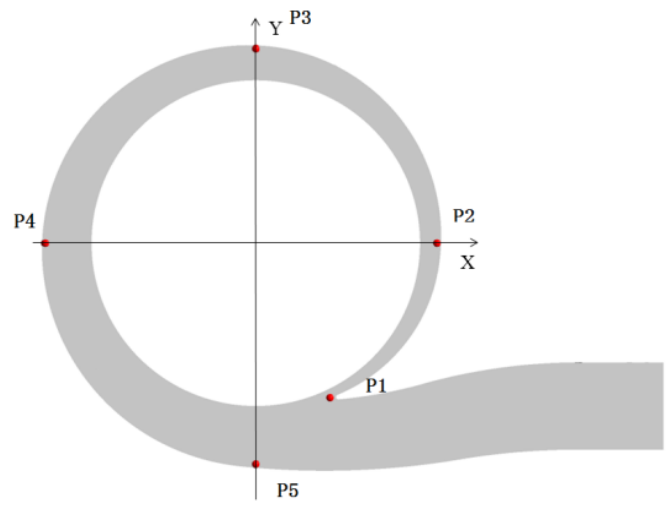
Figure 15. Position setting of the pressure monitoring nodes.